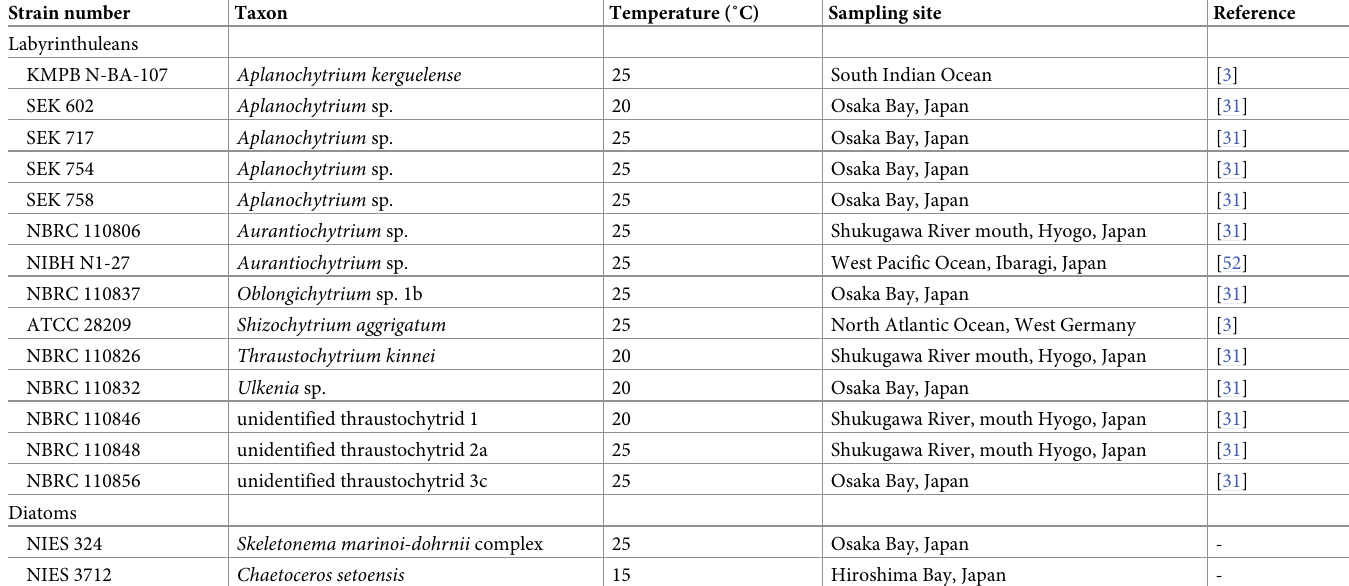
Table 1. Labyrinthulean and diatom strains used in the